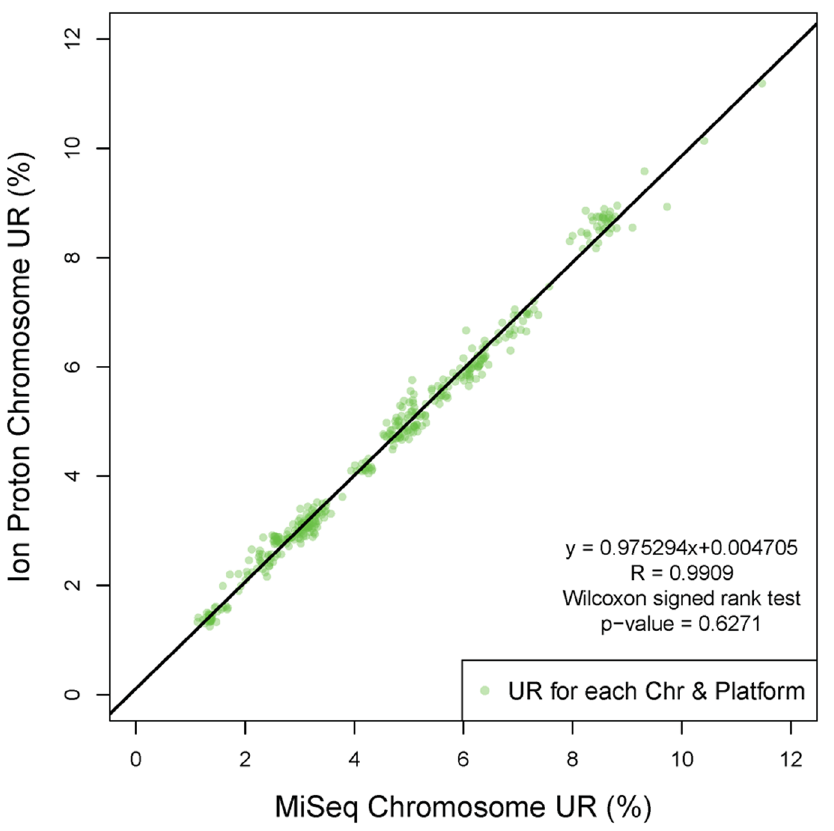
Figure 2. The linear relation between UR% from two platforms. The green scatters show the chromosome UR% calculated using data generated on Miseq (x-axis) and Ion Proton (y-axis) platform, respectively. The linear regression (black line) indicated a good consistency between these two platforms, with a slope of 0.9753, inception of 0.0047 and R 2 of 0.9909.